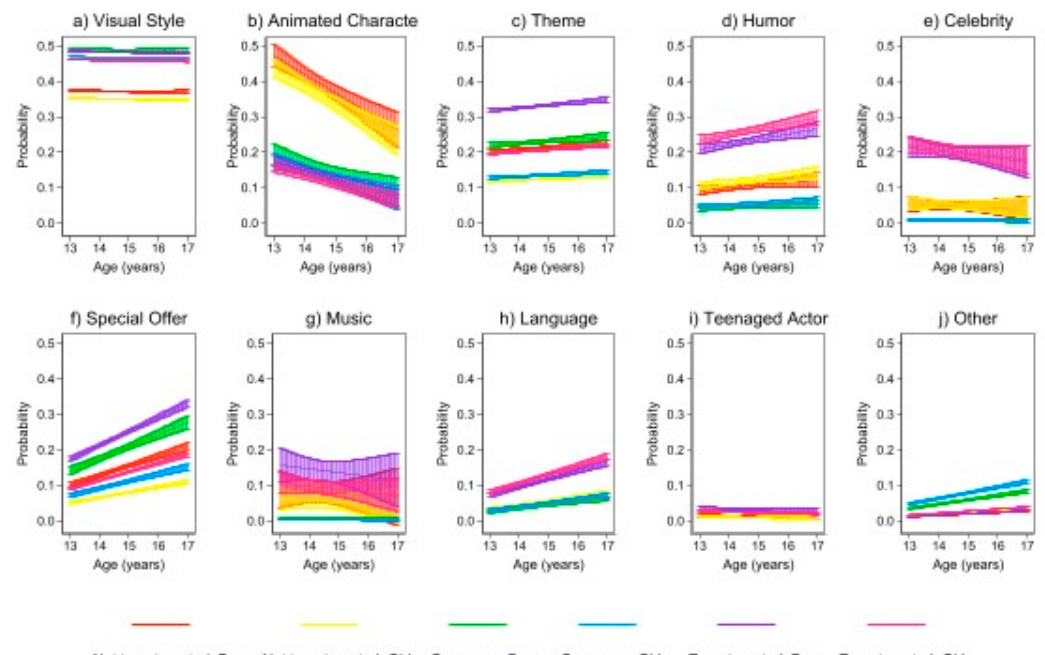
Figure 2. The probability of selecting teen-targeted indicators by gender and